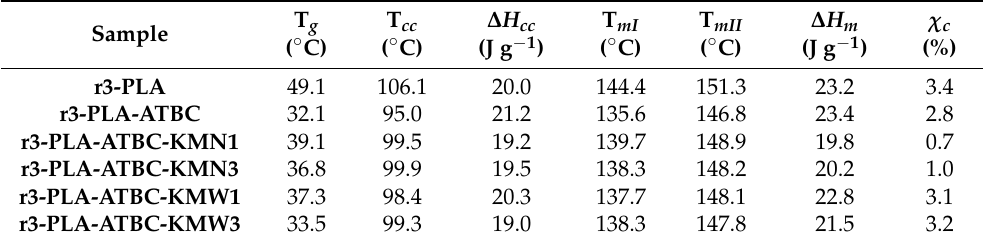
Table 2. DSC thermal properties of 3r-PLA-ATBC-based